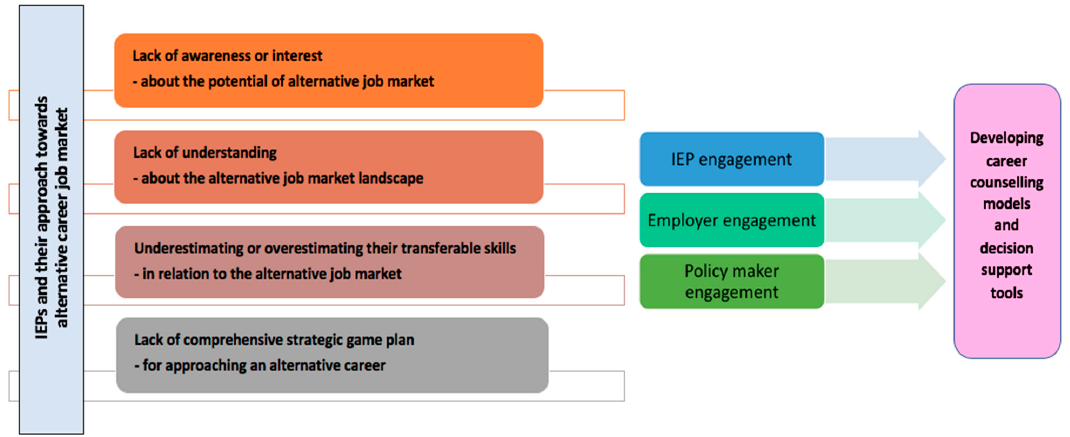
Figure 1. IEPs and alternative career approach issues. IEP: internationally educated